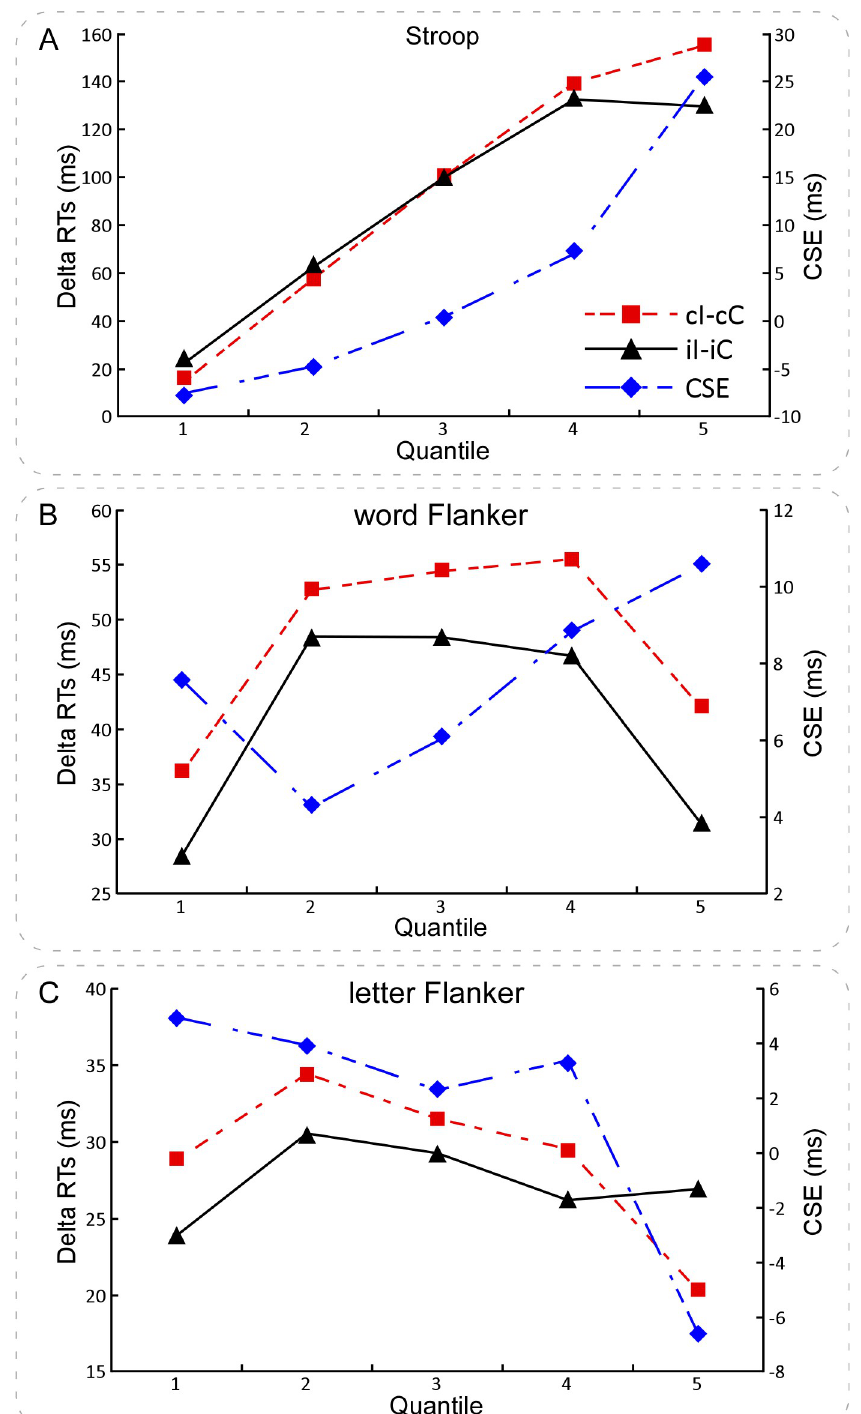
Fig 4. The RT distributions of congruency sequence effect in the Stroop, word Flanker, and letter Flanker tasks. Panels A, B, & C illustrate the time courses of congruency sequence effect in Experiments 1, 2, & 3, respectively. The congruency sequence effect, RTs (cI–cC) , and RTs (iI–iC) were calculated over five quantiles in RTs of each participant and condition. Panel A depicts the time course of congruency sequence effect in the Stroop task. Noteworthy is that congruency sequence effect, RTs( cI–cC) , and RTs (iI–iC) increased across all five quantiles. Panel B depicts the time course of congruency sequence effect in the word Flanker task. The negative slope between the first two